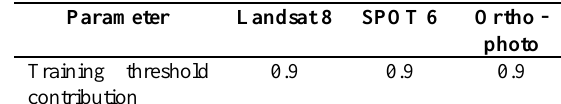
Table 3. Parameter setting in neural